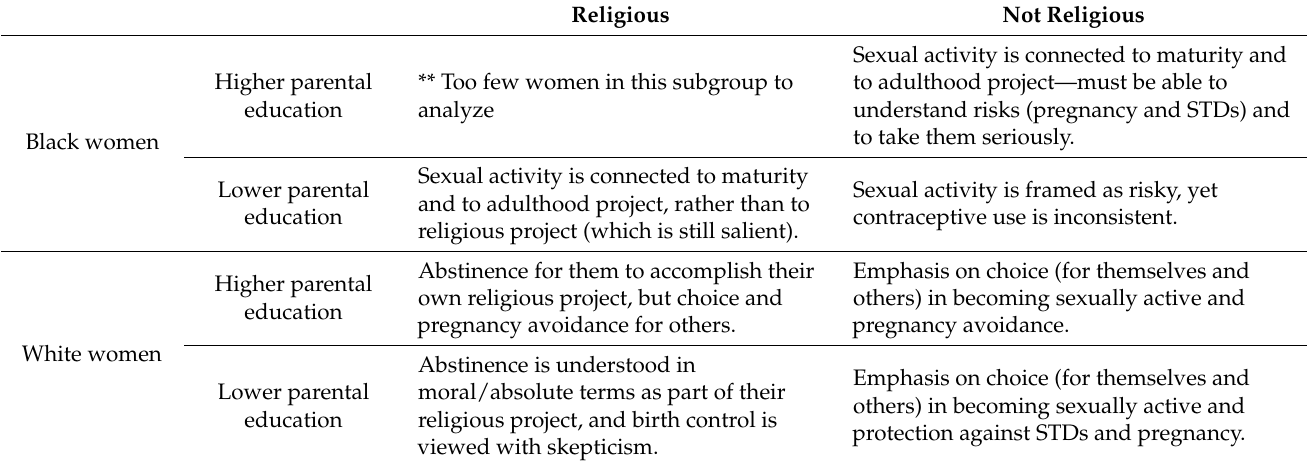
Table 5. Sexual Projects across Race, Parental Education, and Religiosity.